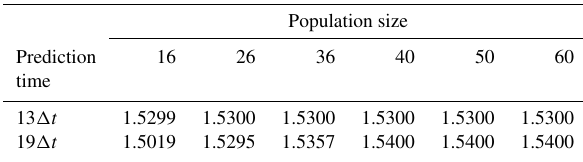
Table 5. Same as Table 4, except that 40 CNOPs are produced by